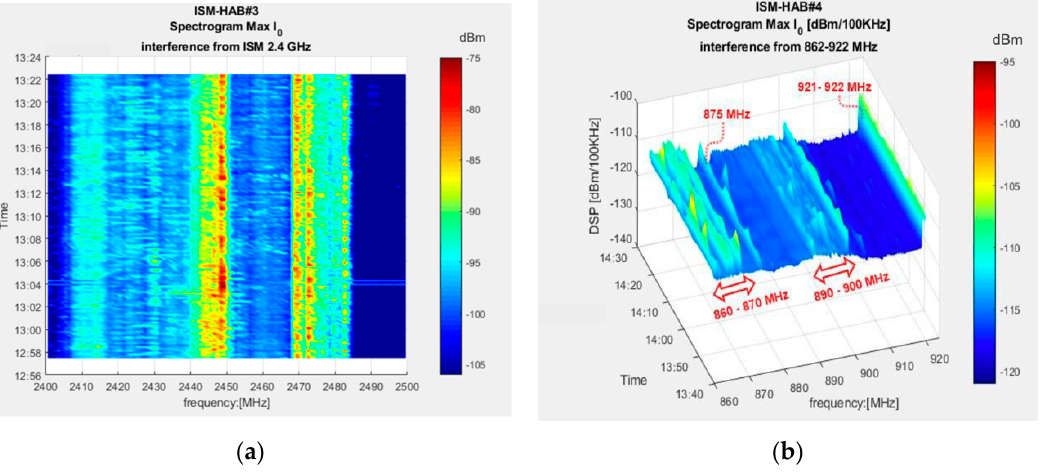
Figure 13. Interference spectrograms: ( a ) 2.4 GHz and ( b ) 862–922 MHz.